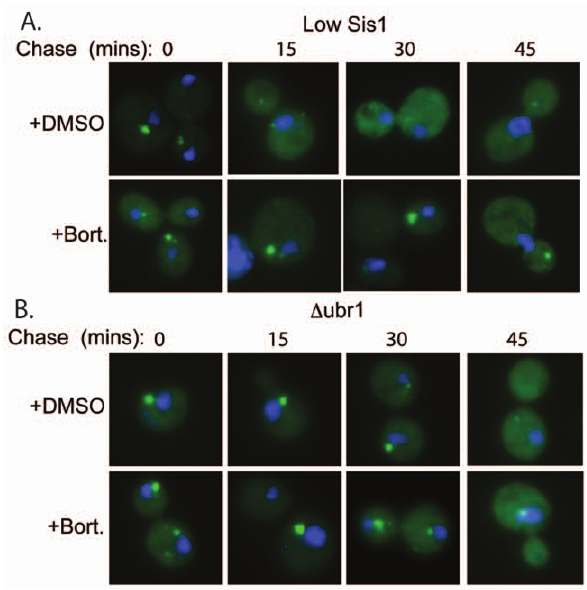
Figure 8. Behavior Of SlGFP Puncta In Cycloheximide Chase Experiments. Time course of slGFP puncta stability in A) low Sis1 or B) D ubr1 . Strains that express slGFP were grown to mid-log phase and then treated either DMSO or 100 m M bortezomib for 20 min. Cycloheximide was added and cells were incubated for the indicated time and then fixed. slGFP in DAPI stained cells was visualized by fluorescence microscopy.